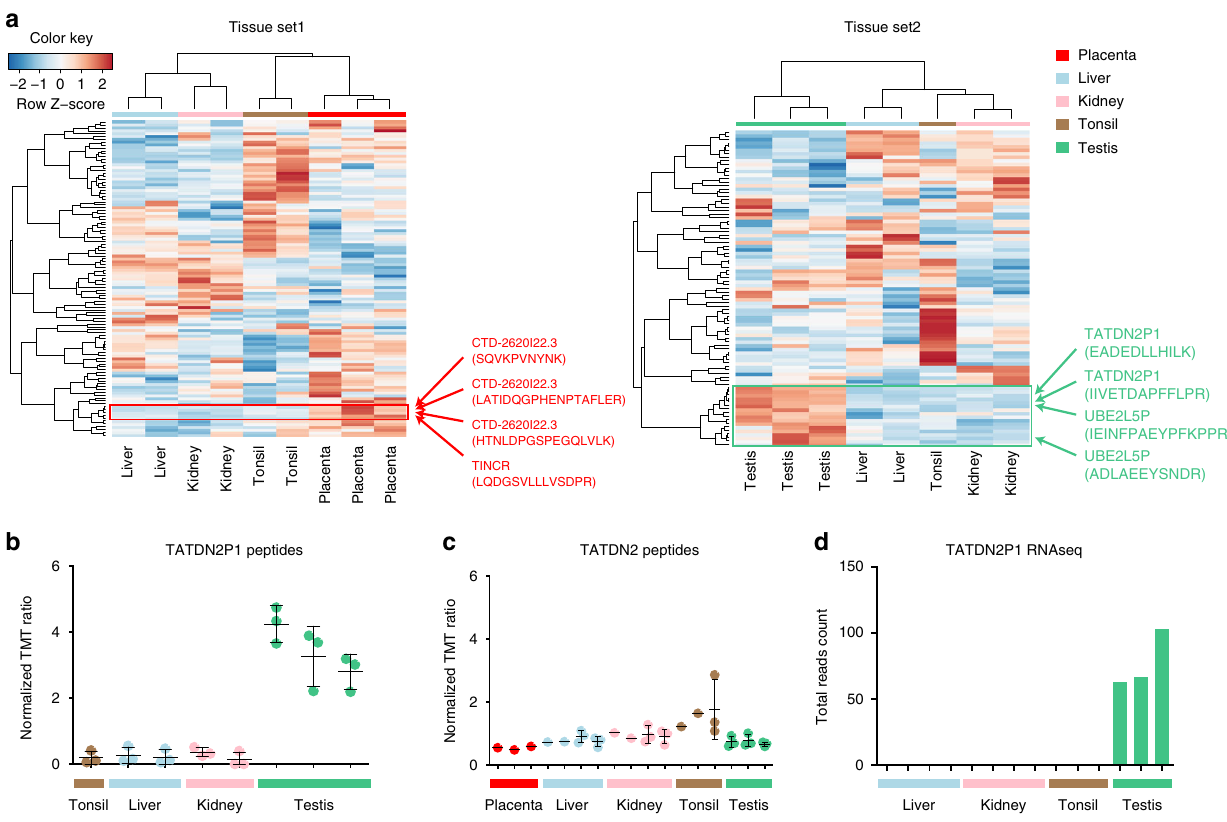
Fig. 6 Quantitative analysis of novel peptides identi fi ed in the normal tissues data set. a Novel peptide tissue expression. Pearson correlation and complete linkage method was used for clustering. Row Z -scores are shown in the heat map. b TMT-based tissue quanti fi cation of the pseudogene TATDN2P1 peptides points to testis speci fi city. The three dots in the TMT ratio plots indicate quanti fi cation of three individual PSMs, with the center bar as the mean and error bars as standard deviation. c TMT-based tissue quanti fi cation of TATDN2 peptides indicates broad tissue expression (quanti fi cation values from three PSMs). d RNA-seq read counts of TATDN2P1 in different tissues con fi rms testis speci fi